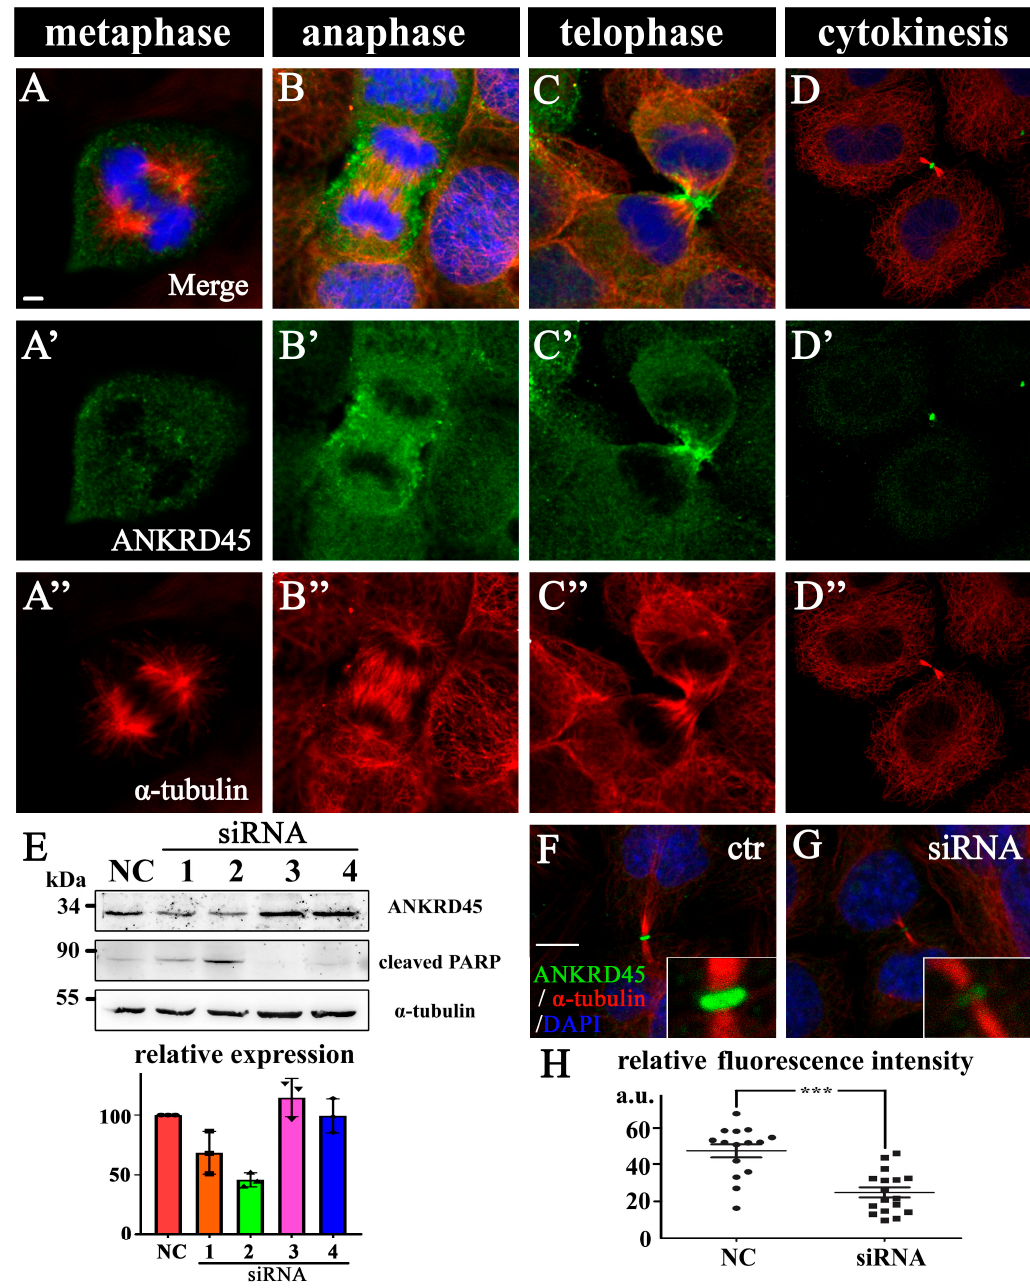
Figure 3. Subcellular localization of ANKRD45 during mitosis. ( A–D’’ ) Subcellular localization of ANKRD45 during mitosis in human hepatoma Hep3B cells. The distribution of ANKRD45 was visualized with anti-ANKRD45 antibody (green). The cytoskeleton was stained by anti- α -tubulin antibody (red) and nuclei were labeled with DAPI (blue). ( E ) Hep3B cells were treated with control or four siRNAs against ANKRD45 and analyzed with Western blotting using ANKRD45 antibody or a cleaved form of the PARP antibody. The α -tubulin antibody was used as a loading control. Bottom bar graph shows the statistical results of ANKRD45 expression in control or siRNA-treated cells from the immunoblots results. ( F–G ) Confocal images showing the localization of ANKRD45 in the midbody during cytokinesis in control ( F ) or siRNA#2 ( G ) treated HeLa cells. ( H ) Quantitative analysis of relative ANKRD45 expression in the midbody ring of control or siRNA#2-treated HeLa cells. NC, negative control. Scale bars: 5 μ m. *** p < 0.001.